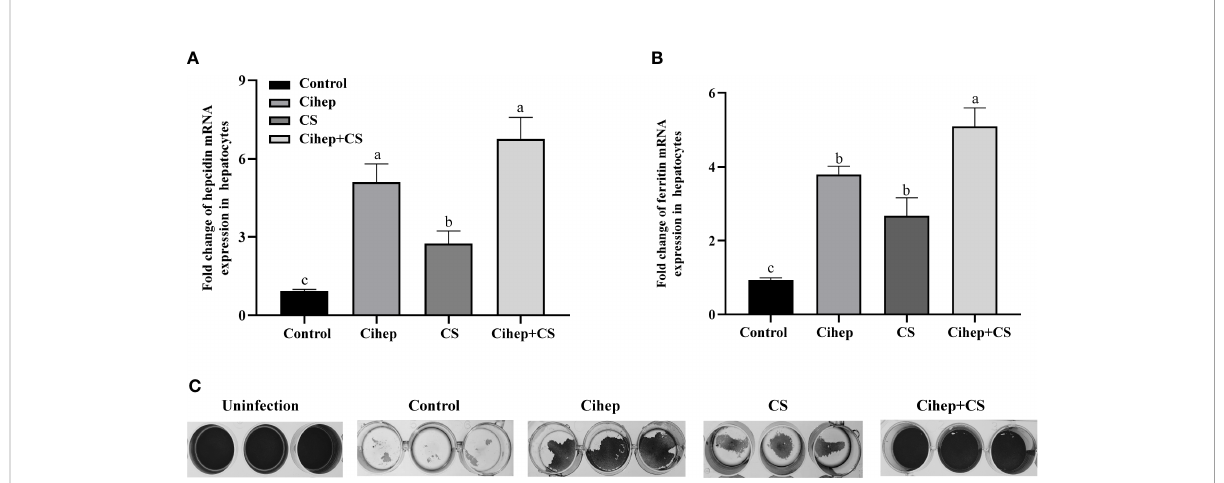
FIGURE 2 Preventive effects of Cihep and CS in L8824-infected bacteria by iron metabolism. (A) qRT-PCR assay of mRNA level of hepcidin in hepatocytes treated with Cihep and CS. (B) Fluorescence assay of LIP level in hepatocytes treated with Cihep and CS. (C) Bacterial suspension in M199 was incubated with L8824 cells for 3 h and then treated with PBS, Cihep, CS and Cihep+CS at 28°C for 24 h. Cell density was determined using crystal violet staining. Uninfected cells were used as blank control. Different small letters in each group (a, b, and c) denote signi fi cant variations suggested by the multifactorial ANOVA statistics (p <